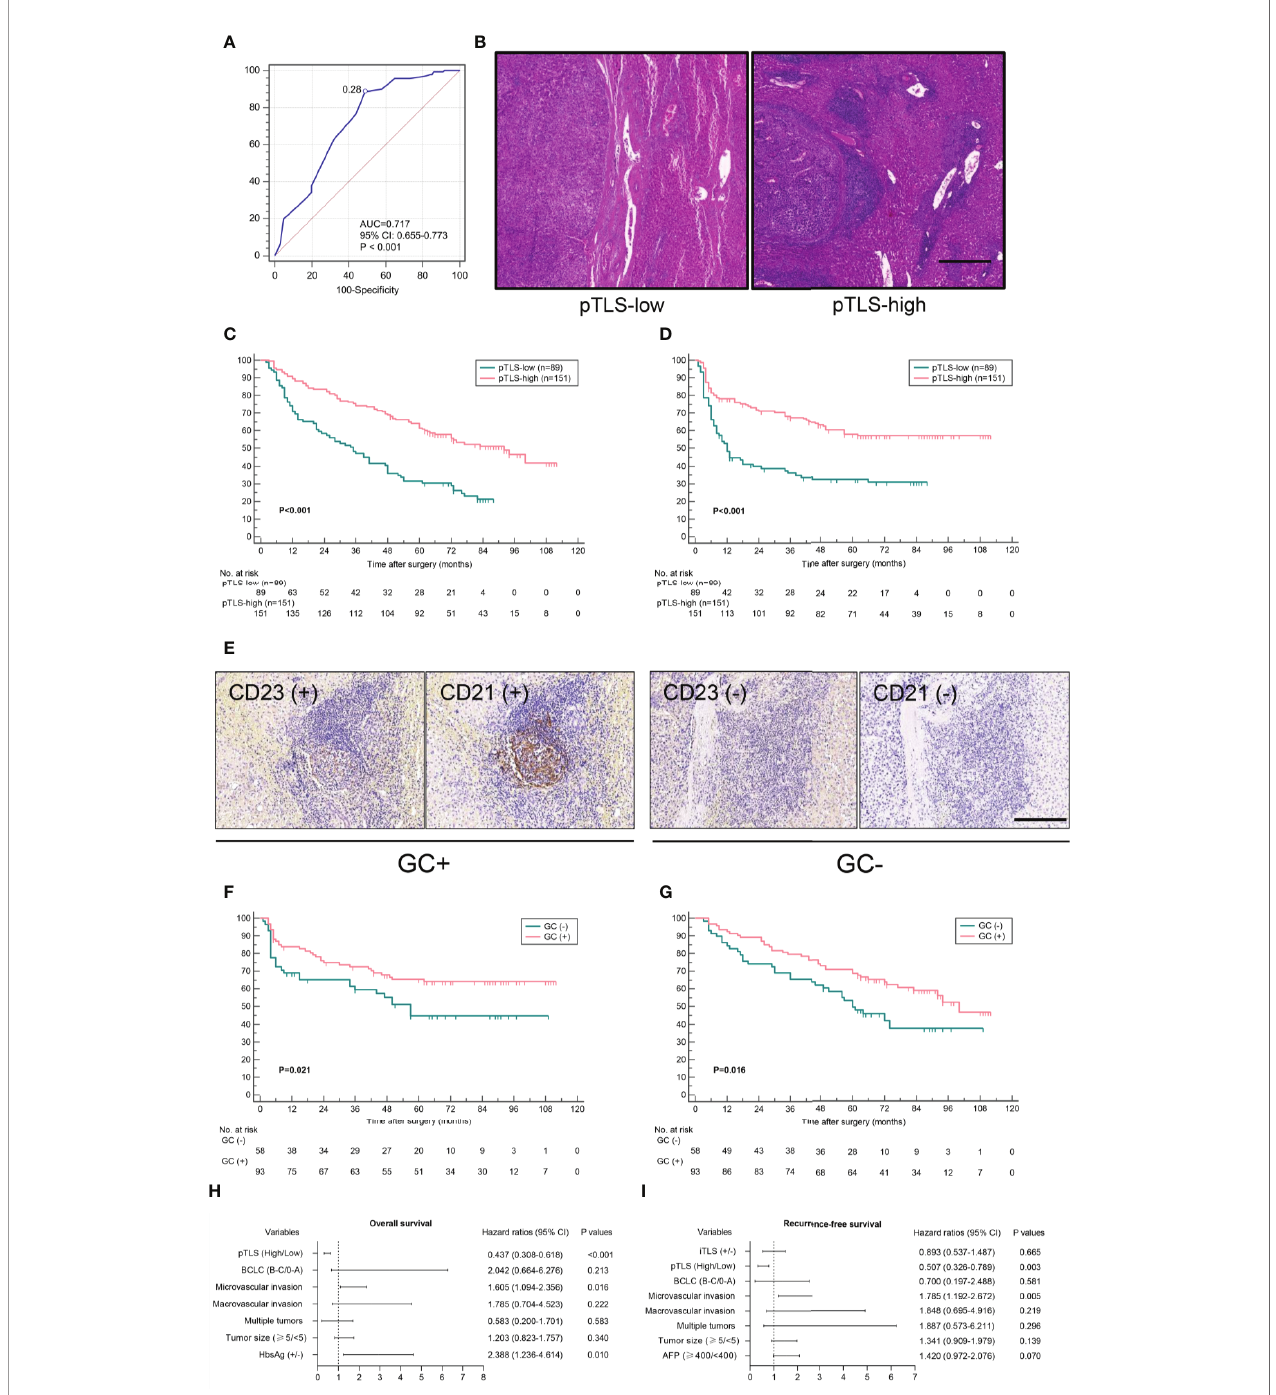
FIGURE 2 | The density of pTLS correlates with patient survival outcomes. (A) , ROC curve analysis was used for identi fi cation of optimal cut-off value of pTLS density to separate pTLS-low and pTLS-high tumors with prognostic relevance. (B) Representative images of pTLS in pTLS-low group (<0.28 pTLS/mm 2 , left panel) and pTLS-high group (right panel) in H&E stained sections. Scale bar, 500 m m. (C, D) Kaplan-Meier curves were used for comparison of OS and RFS among patients with low or high pTLS density in training cohort. Signi fi cance was tested by log-rank test. (E) Representative images of GC (+) TLS (left) and GC (-) TLS in human HCC specimens by staining with CD21 and CD23. Scale bar, 50 m m. (F, G) Kaplan-Meier curves for OS and RFS in 151 patients with high pTLS density, according to the presence of GC or not. Signi fi cance was tested by log-rank test. (H, I) Multivariate analyses were performed to identify prognostic factors of OS and RFS in 240 HCC patients. pTLS, peritumoral tertiary lymphoid structure; ROC, receiver operating characteristics; AUC, area under curve; OS, overall survival; RFS, recurrence-free survival; GC, germinal